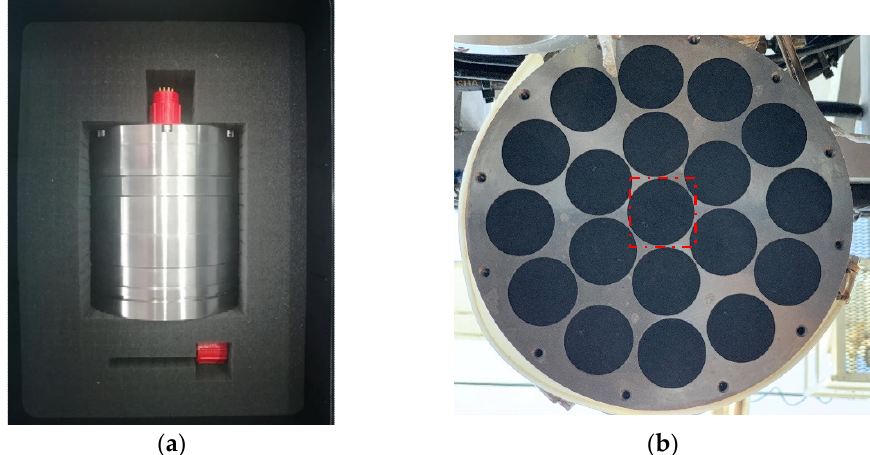
Figure 1. The photo of Programmable Phased Parametric Array Acoustic Probe 2019 (PPPAAP19): ( a ) Front view of PPPAAP19; ( b ) the designed array located at the bottom of PPPAAP19 with the receiving transducer marked with red and the other 18 transmitting transducers around it.